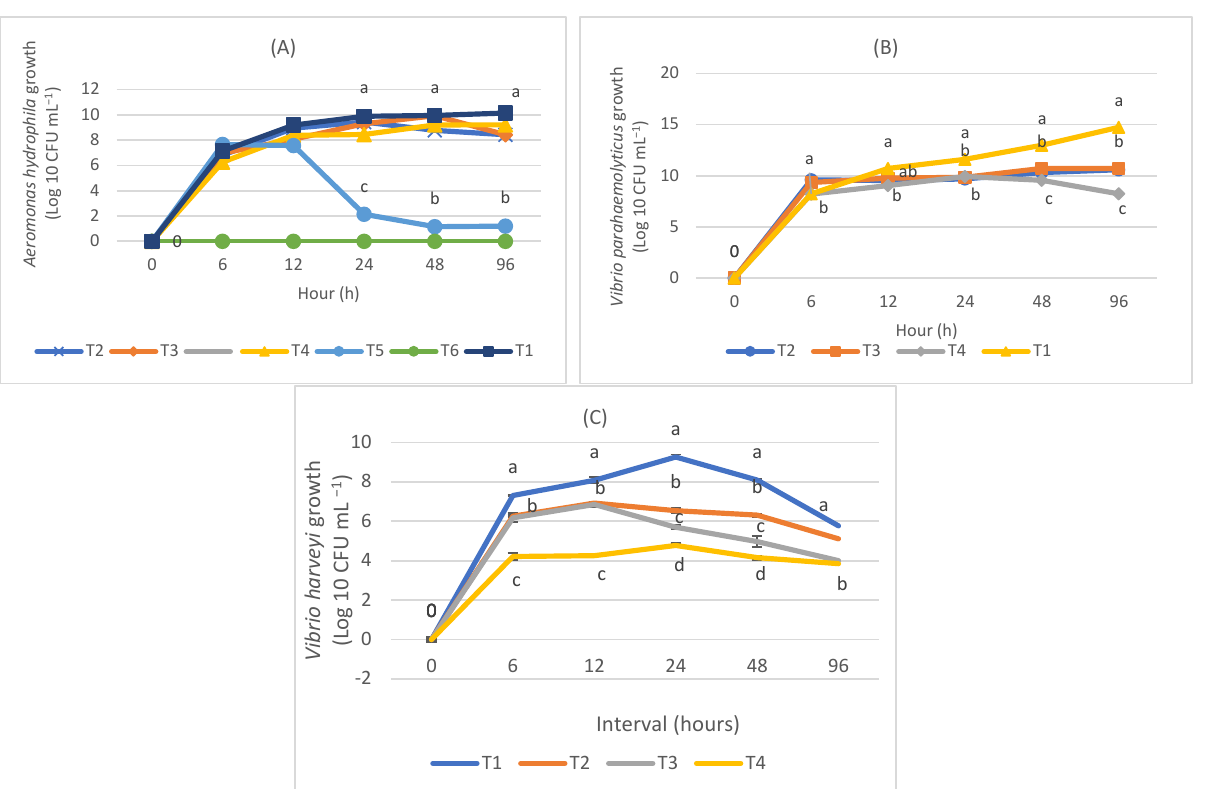
Figure 2. ( A ) The growth pattern of A. hydrophila incubated with different concentrations of MSP1 L11 + LAB3 + SPS11 (10 4 , 10 5 , 10 6 , 10 7 , and 10 8 CFU mL − 1 ) against time. T1 ( A. hydrophila 10 6 CFU mL − 1 ), T2 (MSP 10 4 CFU mL − 1 + A. hydrophila 10 6 CFU mL − 1 ), T3 (MSP1 10 5 CFU mL − 1 + A. hydrophila